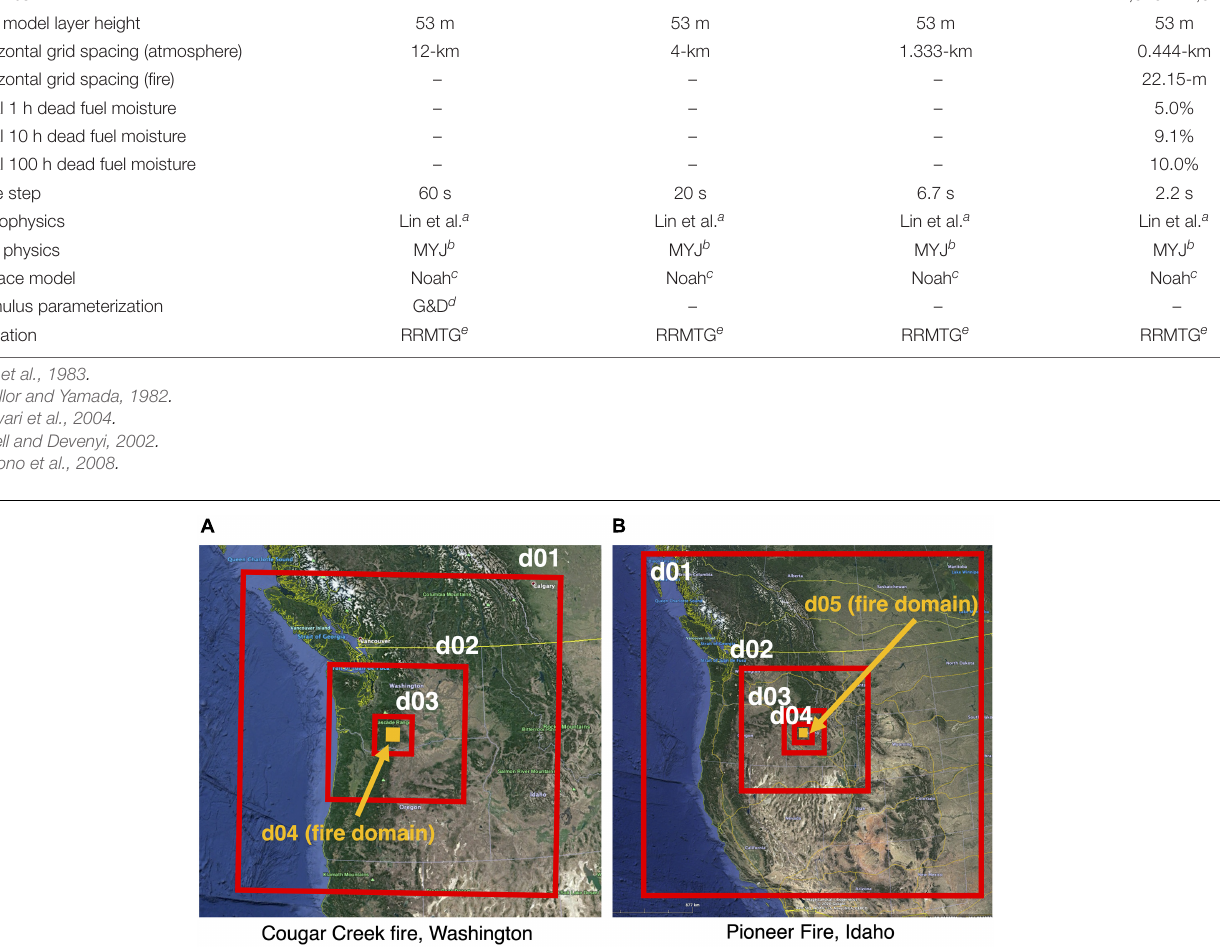
FIGURE 1 | Domain configuration for the (A) Cougar Creek Fire, (B) Pioneer Fire. Orange box indicated the innermost domain used for fire spread